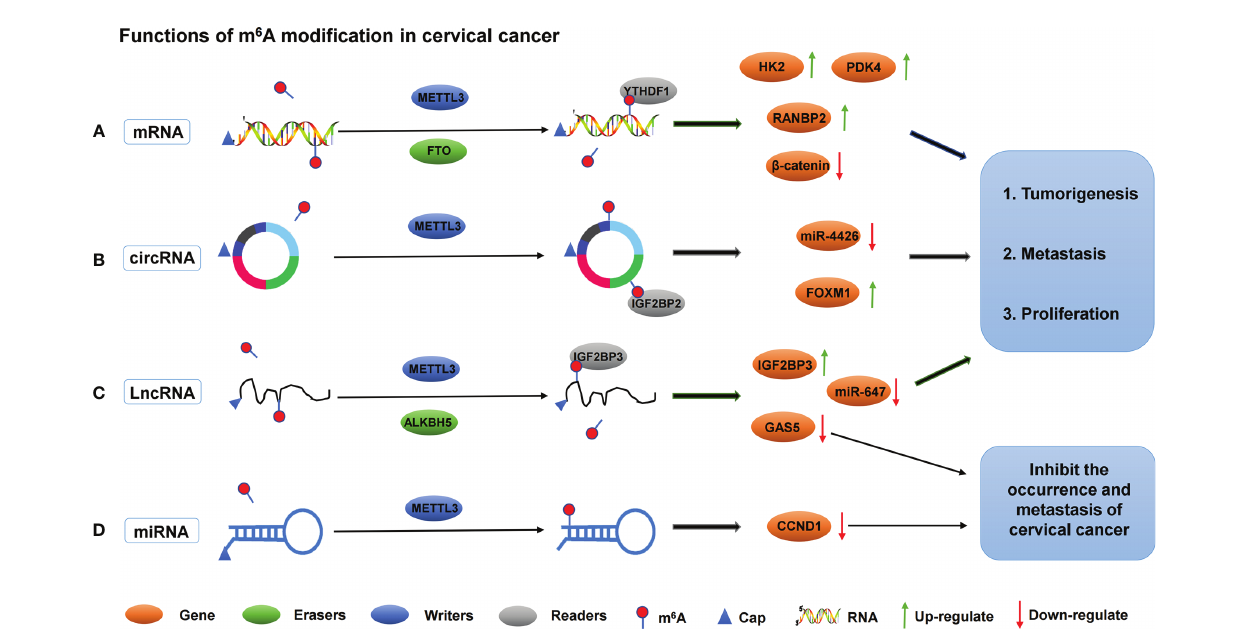
FIGURE 2 | The roles of different m 6 A regulators in regulating RNAs in cervical cancer. (A) m 6 A methylation regulators METTL3, FTO and YTHDF1 promote the invasion and metastasis of cervical cancer by binding to mRNA and regulating mRNA expression. (B) m 6 A methylation regulators METTL3 and IGF2BP2 promote the invasion and metastasis of cervical cancer by binding to circRNA and regulating target genes expression. (C) m 6 A methylation regulators METTL3, ALKBH5 and IGF2BP3 promote/inhibit the invasion and metastasis of cervical cancer by binding to lncRNA and regulating target genes expression. (D) m 6 A methylation regulators METTL3 inhibit the invasion and metastasis of cervical cancer by binding to lncRNA and regulating target genes expression.